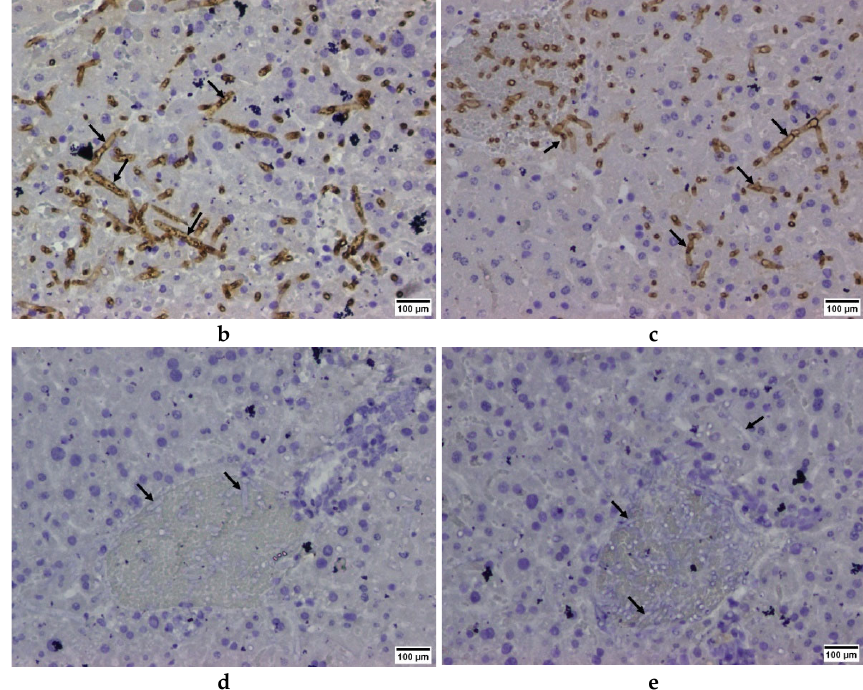
Figure 3. Aspergillus mAbs 1D2 and 4E4 showed immunohistochemical staining in formalin-fixed paraffin liver sections from Aspergillus fumigatus infected mice. ( a ) Haematoxylin and eosin staining showed that the hepatic lobule structure was disordered with radial structure appearing, the central hepatic vein was expanded, congested and full of red blood cells (triangles); the hepatocytes were swollen and partly fused with a shrinking or disappearing nucleus; the A. fumigatus hyphae infiltrated the blood vessels (arrow), with no obvious neutrophil infiltration. ( b – e ) Immunohistochemistry staining indicated both mAbs 1D2 ( b ) and 4E4 ( c ) showed significant signals on the hyphal wall (black arrow) of A. fumigatus . There was no immunoreactivity observed in isotype group ( d ) and blank control ( e ) group.